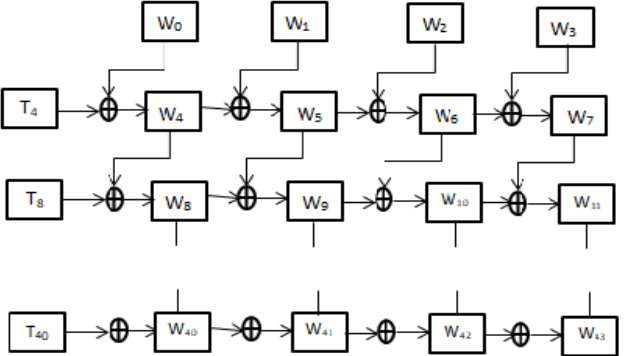
Figure 1. Existing Key Expansion Architecture.